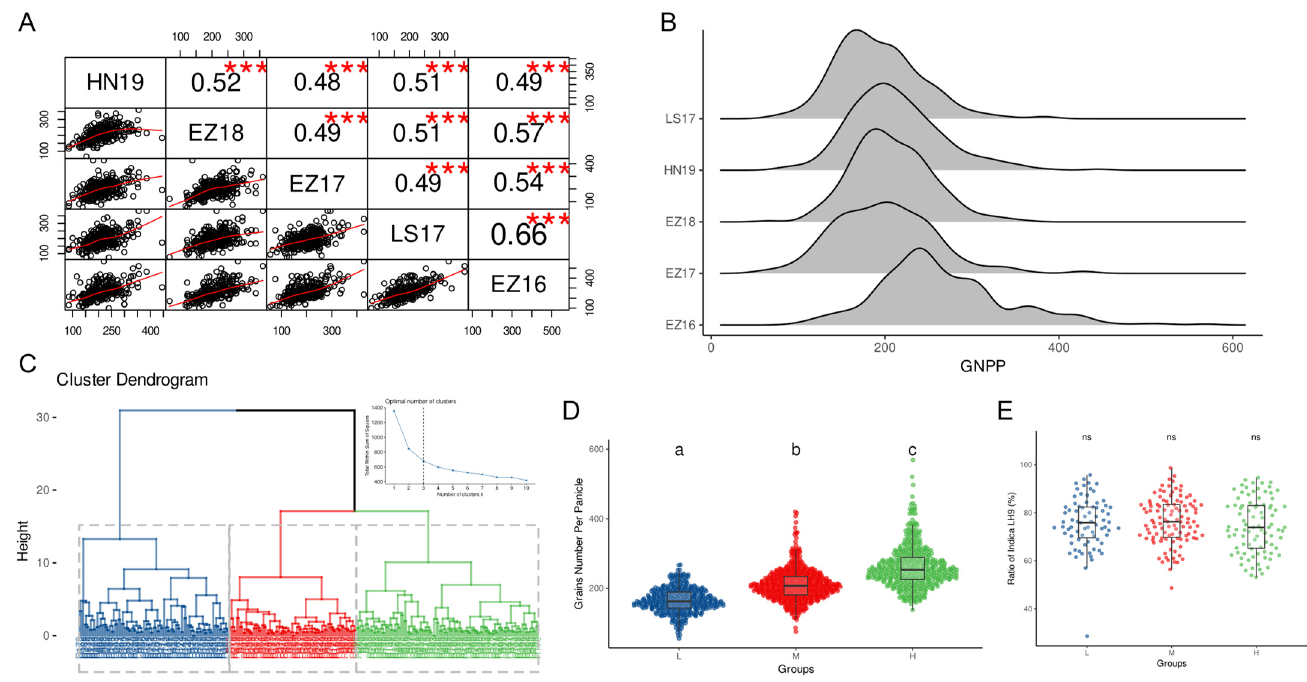
Figure 1. Distribution of Grain Number per Panicle of the RILs population. ( A ) Correlation analysis of the GNPP of rice in five times plantings of the RILs population; ( B ) distribution of GNPP of the RILs population; ( C ) the hierarchical clustering result of RILs population according to distribution of GNPP—blue indicates Low, red indicates Medium and green indicates High; ( D ) differences in the GNPP between L, M and H groups; ( E ) consanguinity rate of female indica LH9 rice in L, M and H groups. *** indicates p value < 0.001. Different alphabets denote significant difference and vice versa. ns indicates no significant difference.